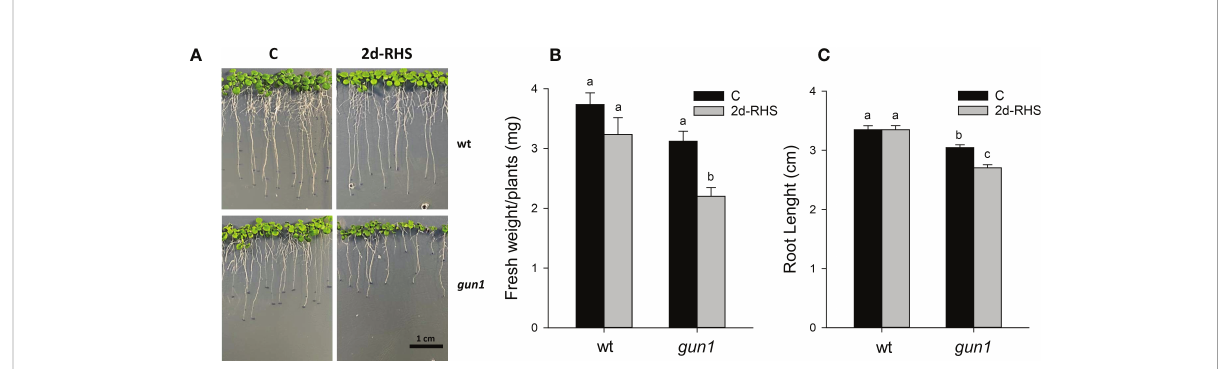
FIGURE 1 Growth parameters of 17-day-old wt and gun1 plantlets, grown at control temperature (C) or subjected, after 15 days, to Heat Stress (HS; 2 hours at 45°C), followed by long-term recovery (2d-RHS; 2 days at 22°C). (A) Representative image of visible phenotypes, (B) Fresh Weight and (C) Root Length of plantlets measurements. The values are the means ± standard errors of fi ve independent experiments. Different letters indicate signi fi cant differences obtained by one-way ANOVA test (P<